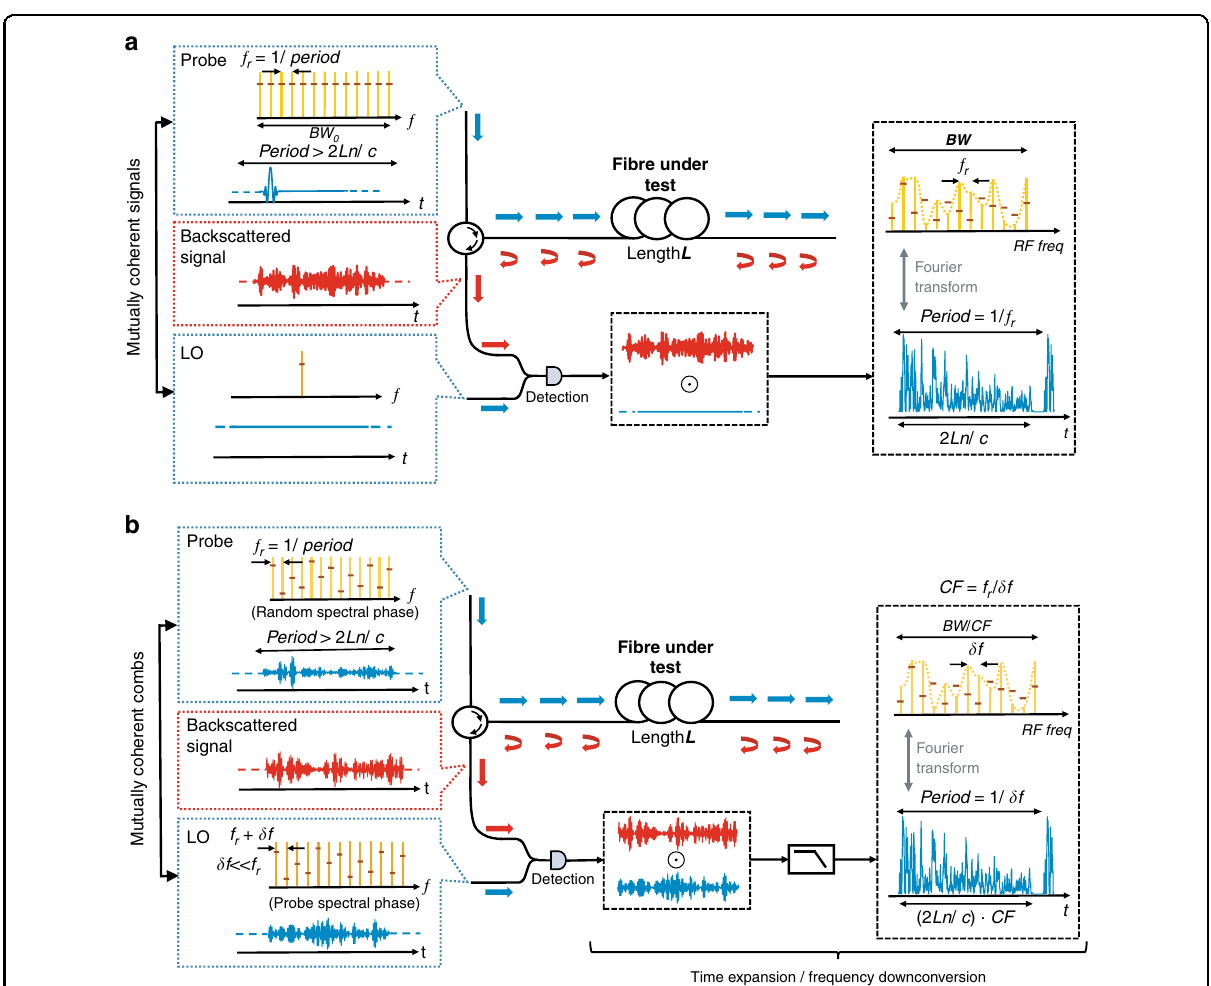
Fig. 1 Concept of time-expanded Φ OTDR. a An example of a traditional coherent detection-based Φ OTDR scheme. A train of optical probe pulses (with a comb-like spectrum composed of in-phase lines) is launched into the fi bre under test. The backscattered light is beaten with a continuous- wave local oscillator (LO) and photo-detected. Both the amplitude and phase of the electromagnetic fi eld are acquired over a bandwidth BW identical to that of the launched probe. b Proposed time-expanded Φ OTDR scheme. A periodic probe signal is launched into the fi bre under test. Its spectrum is a random phase-modulated optical comb. The backscattered light is beaten with an LO that is a comb with the same number of lines and identical phase modulation as those of the probe comb but with a line spacing difference δ f . After photo-detection, a low-pass fi lter passes the comb generated by the interference of the lines of the probe with the neighbouring lines of the LO. Both the amplitude and phase of the electromagnetic fi eld are acquired over a compressed bandwidth BW/CF , where CF is the ratio between the probe line spacing and δ f . This produces a trace temporally expanded by a factor CF . In the detection stage of both fi gures (central dashed boxes), the signals that are involved in the product (denoted by the symbol ʘ ) are electromagnetic fi